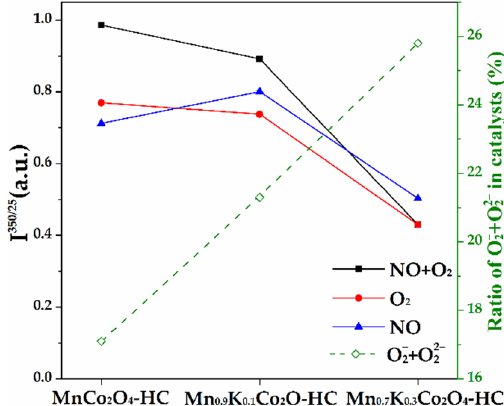
Figure 13. The relationship between in-situ Raman vibration peak intensity and ratio of O 2 − and O 22 − for as-prepared catalysts under laser wavelength of 532 nm. O 22 − for as-prepared catalysts under laser wavelength of 532